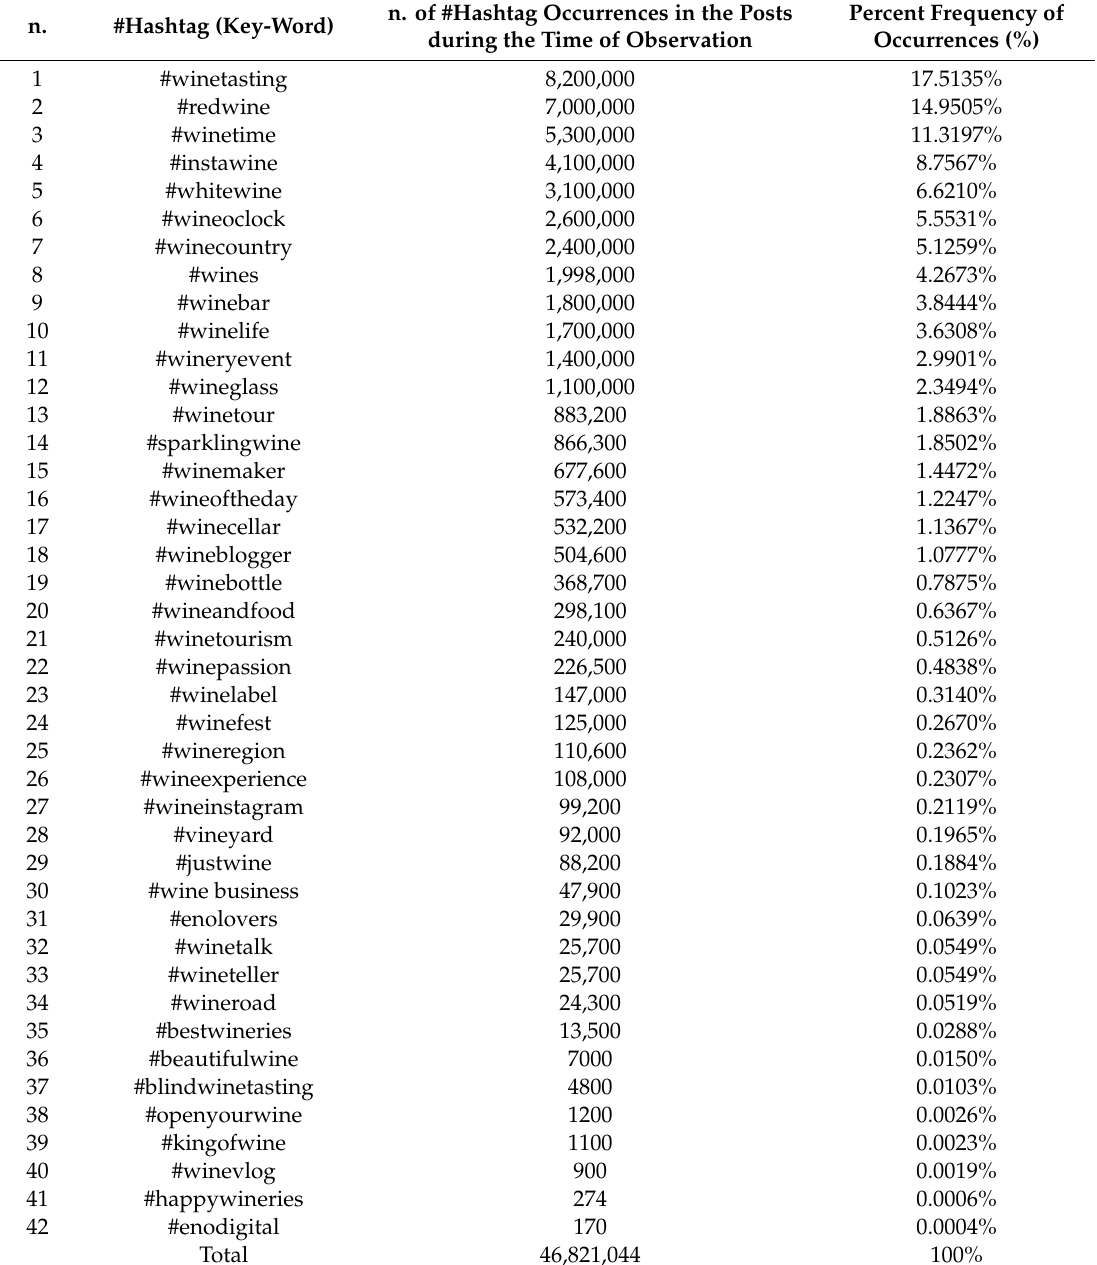
Table 1. #Hashtags observed, number of occurrences and percentage frequencies.